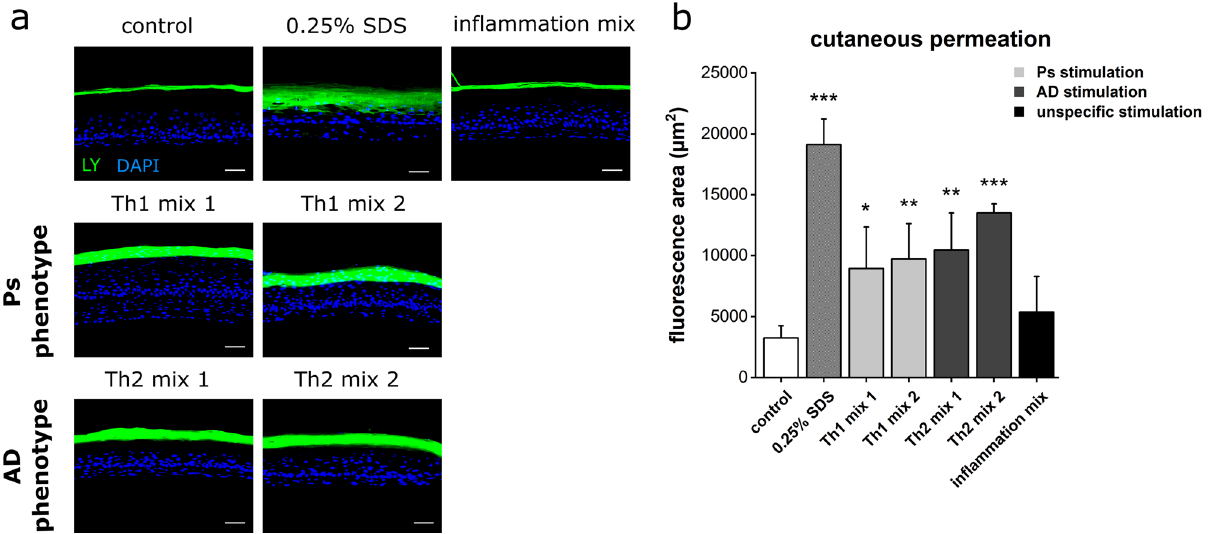
Figure 2. Impaired cutaneous barrier function of disease-associated skin models. ( a ) Penetration of the Lucifer Yellow (LY) fluorescent dye (green) was used to visualize the permeability of skin equivalents stimulated with Th1, Th2 or unspecific inflammatory cytokine mixes compared to an unstimulated physiological negative control. Pretreatment with 0.25% SDS served as permeability control. DAPI (blue) was used for nuclear staining. Scale bar: 50 µm, ( b ) Quantification of LY fluorescence area (mean + SD) of n = 2 experiments with a total of 4 skin models (keratinocytes derived from two different donors). Statistics: one-way ANOVA with Dunett‘s